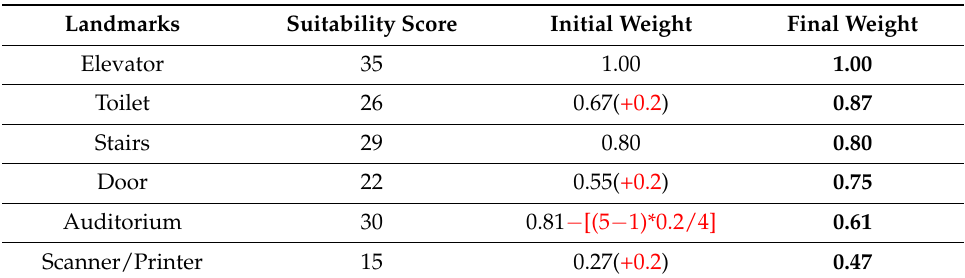
Table 3. Final selected landmarks and their corresponding normalized